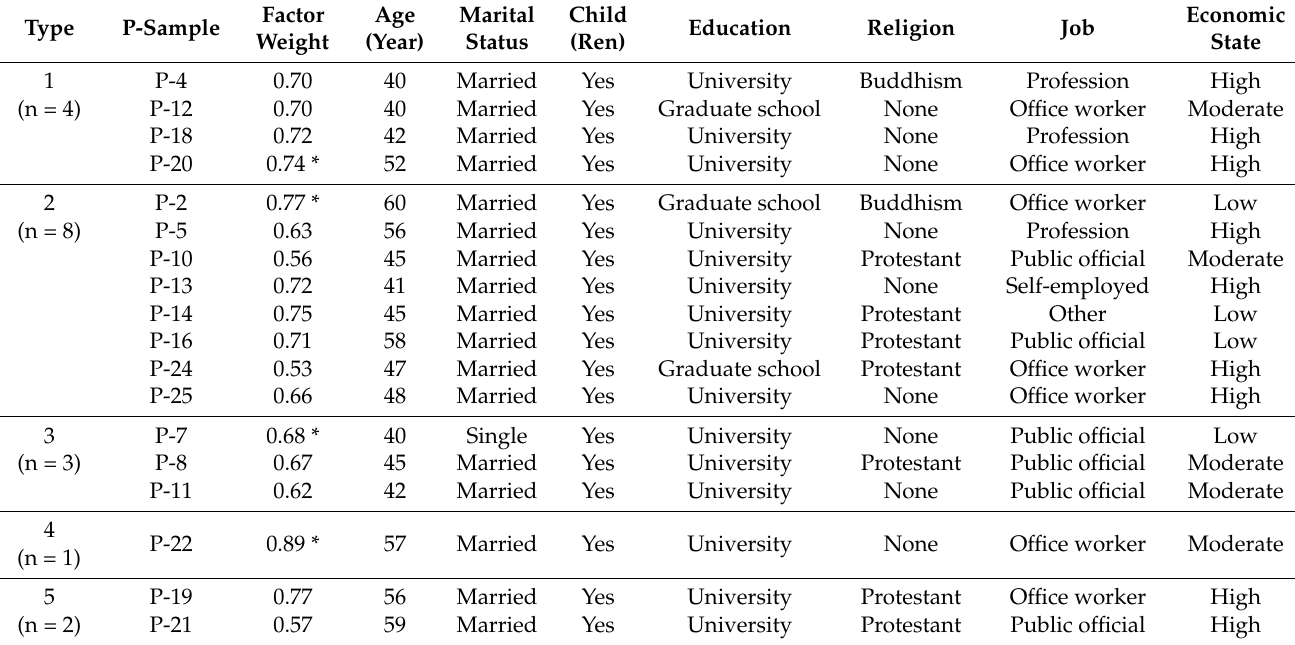
Table 2. Factor weight and general characteristics of P-samples according to type (n = 25). Type P-Sample